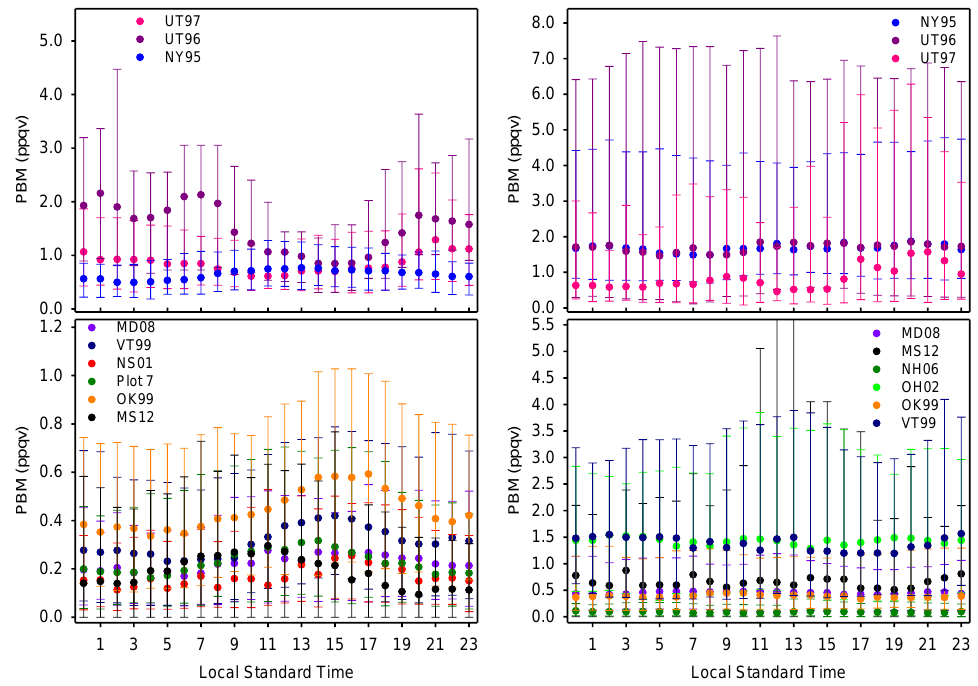
Fig. 8. PBM diurnal variation in 2009 summer (left panel) and winter (right panel). The upper error bars represent 90 percentile while the lower error bars represent 10 percentile values.